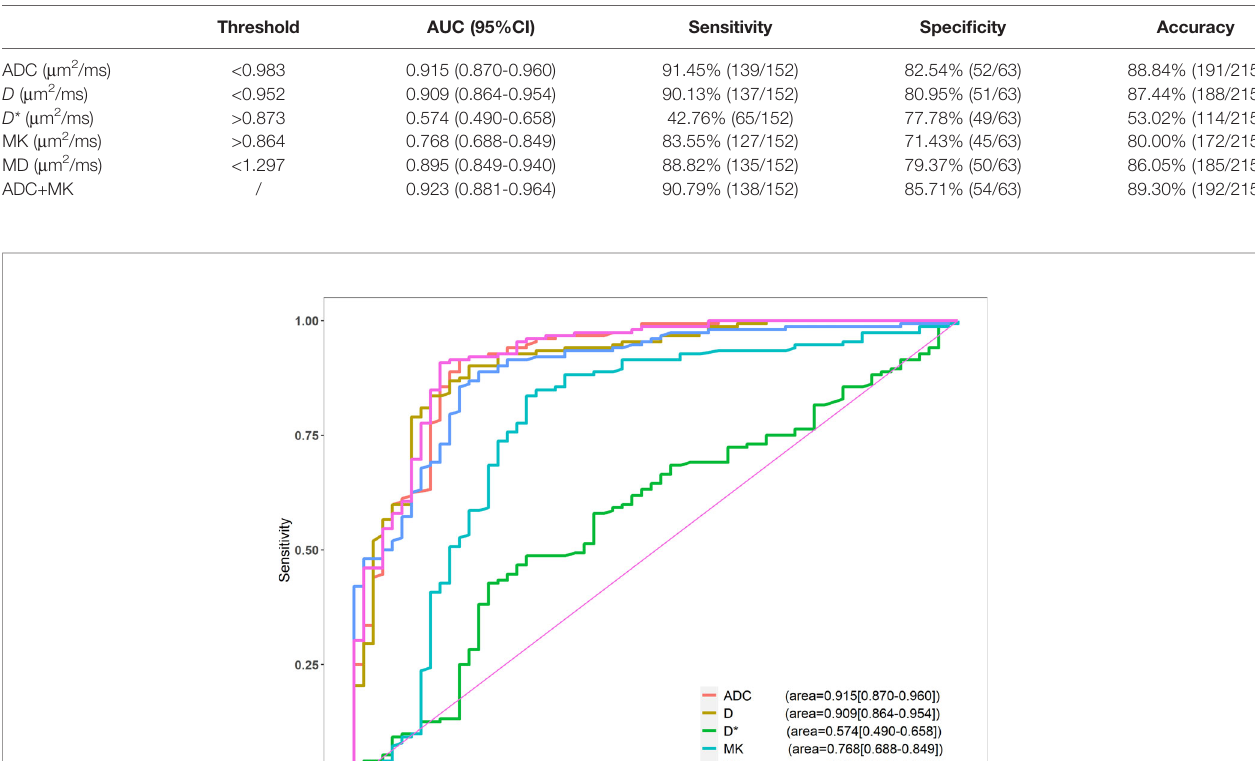
TABLE 2 | The diagnostic performance of single and combined parameters.